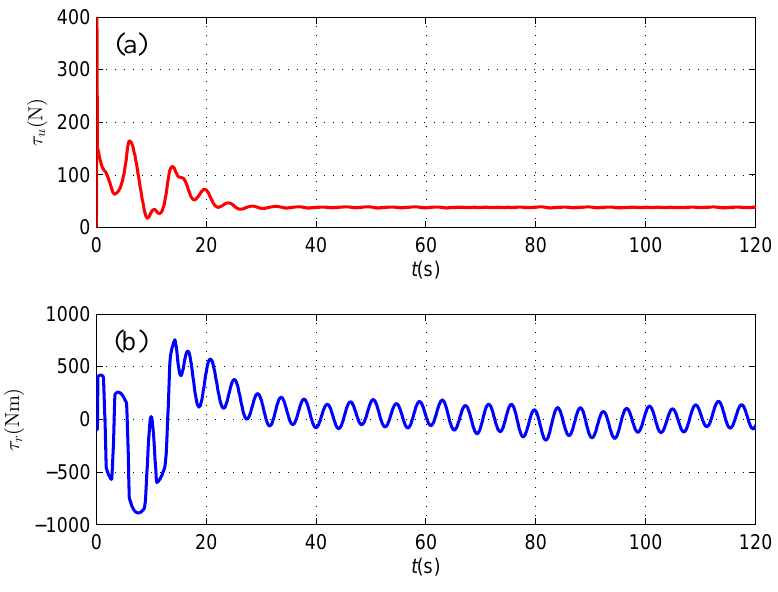
Figure 17. ( a ) Surge control force τ u ; and ( b ) Yaw control moment τ r